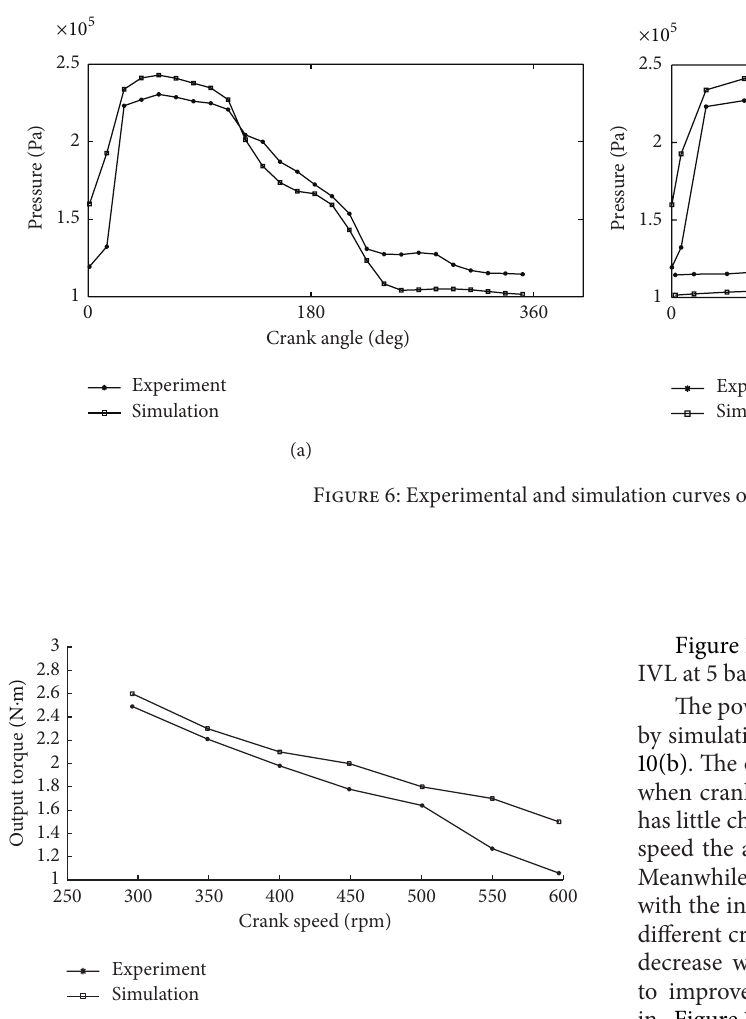
Figure 7: Experiment and simulation curves of output